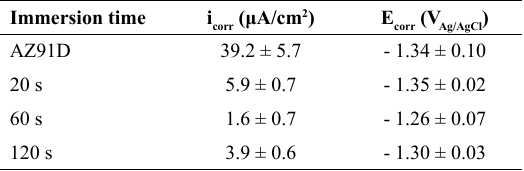
Figure 11. Potentiodynamic polarization curves for uncoated and cerium-coated AZ91D alloy. Electrolyte: 3.5 wt.% NaCl solution at room Table 3. Electrochemical parameters determined from the potentiodynamic polarization curves shown in Figure 11.